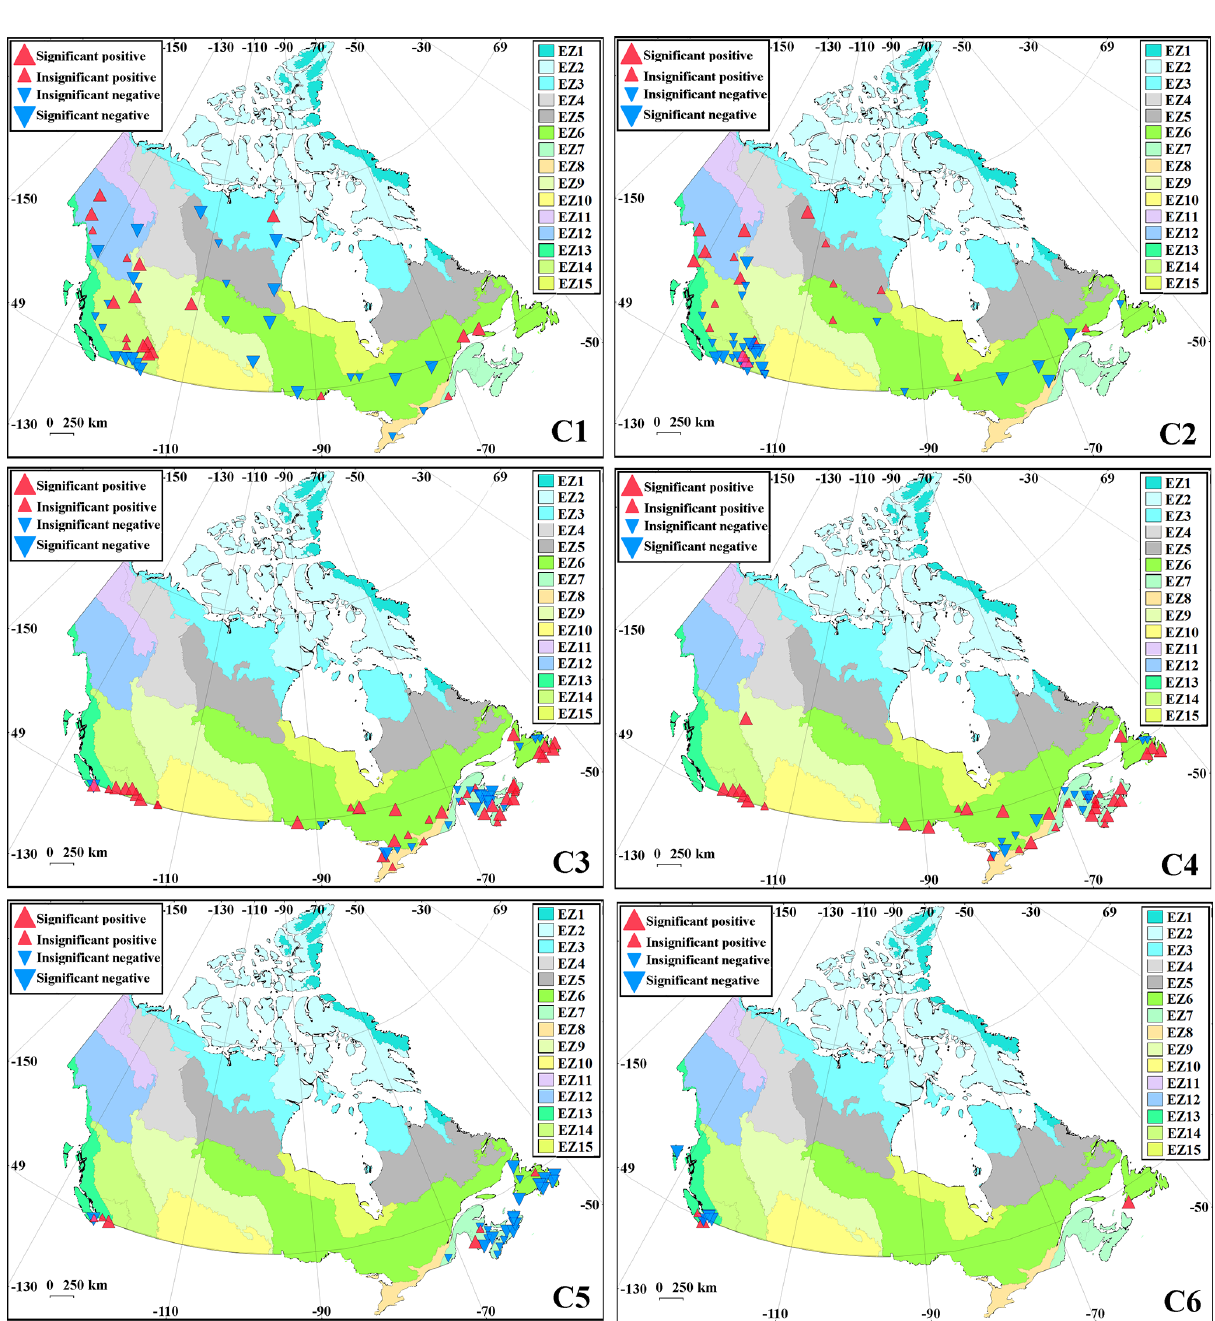
Figure 7. Trends in decadal memberships, quantifying the change in association of the 105 selected RHBN streams to the six regime types during 1966 to